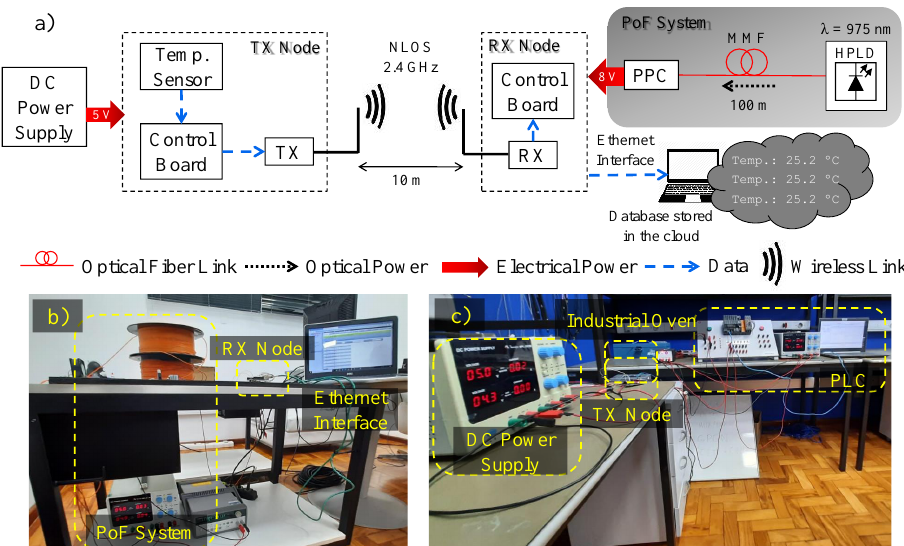
Figure 6. Optically-powered wireless RX node implementation. ( a ) Experimental setup block diagram. ( b ) Experimental setup photograph of the PoF system, RX node, Ethernet interface and the computer. ( c ) Experimental setup photograph of the DC power supply, TX node, industrial oven and PLC. HPLD—high-power laser diode; MMF—multimode fiber; PPC—photovoltaic power converter; TX—transmitter; RX—receiver; NLOS—non-line-of-sight; PLC—programmable logic